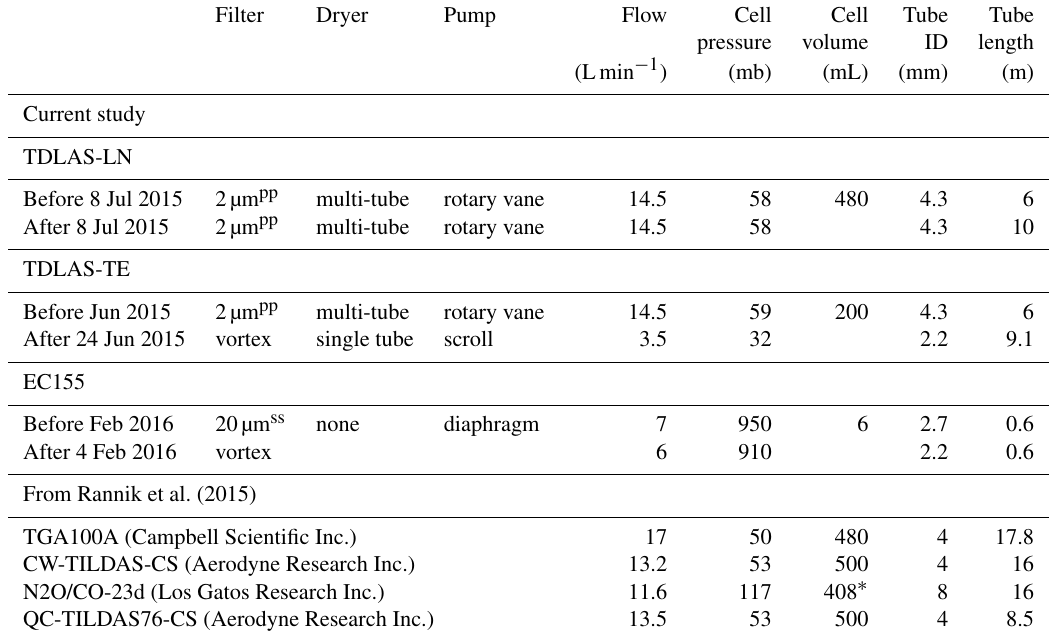
Table 1. Sampling system details for each analyzer throughout the measurement campaign. Changes to equipment during the experimental period are indicated. Operating configurations of N 2 O analyzers used in Rannik et al. (2015) are given for